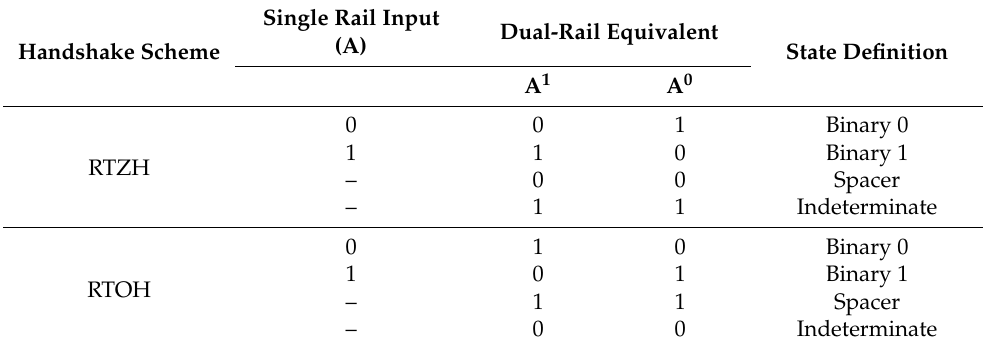
Table 1. Dual-rail data encoding based on four phase RTZH and RTOH. Handshake Scheme